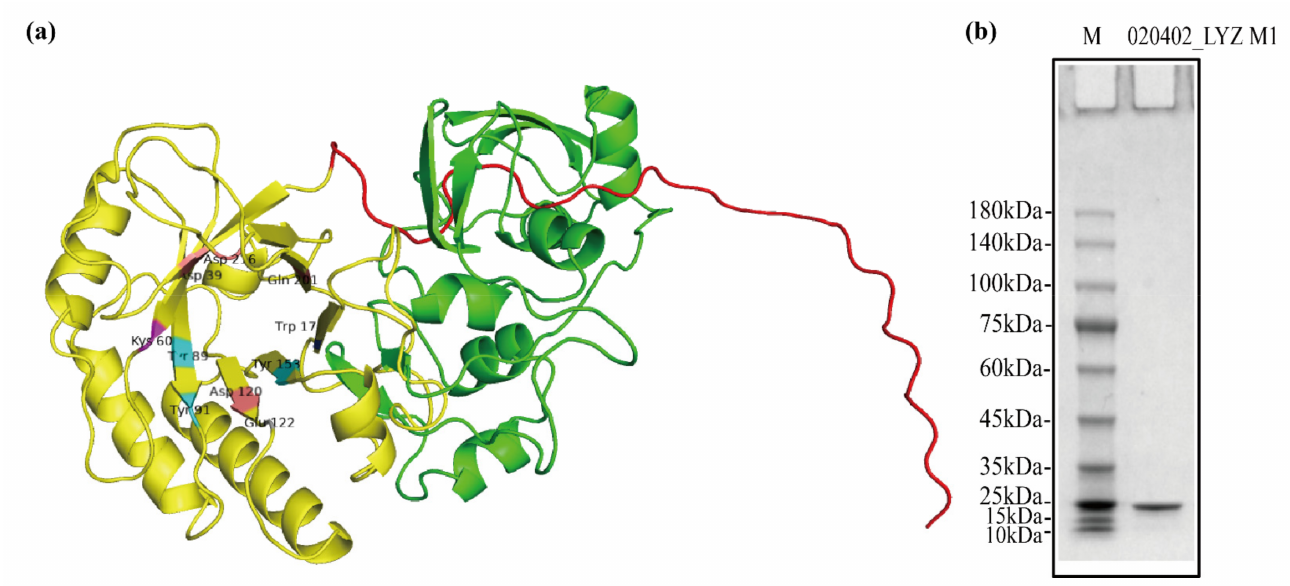
Figure 2. Tertiary structure prediction and gel map. ( a ) Homology analysis and model prediction of the 020402_00271 protein. ( b ) The SDS-PAGE analysis of 020402_LYZ M1 protein, M: